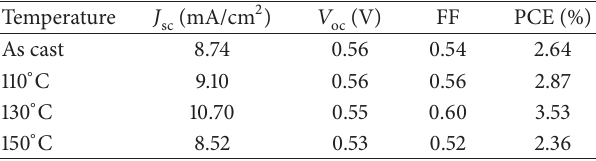
Table 2: Photovoltaic parameters of the devices with differ- ent annealing temperatures, measured under 100mW/cm 2 illu- mination (AM 1.5G). The structure of the devices is